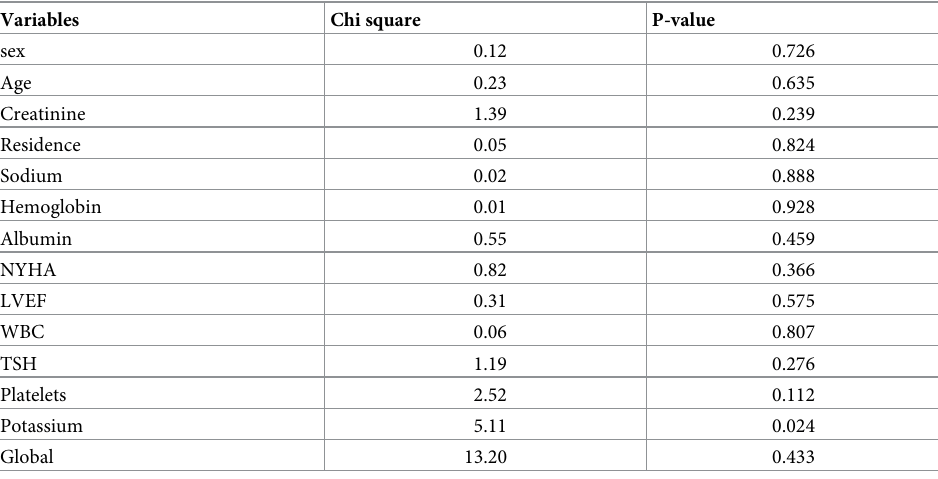
Table 5. Proportional hazards